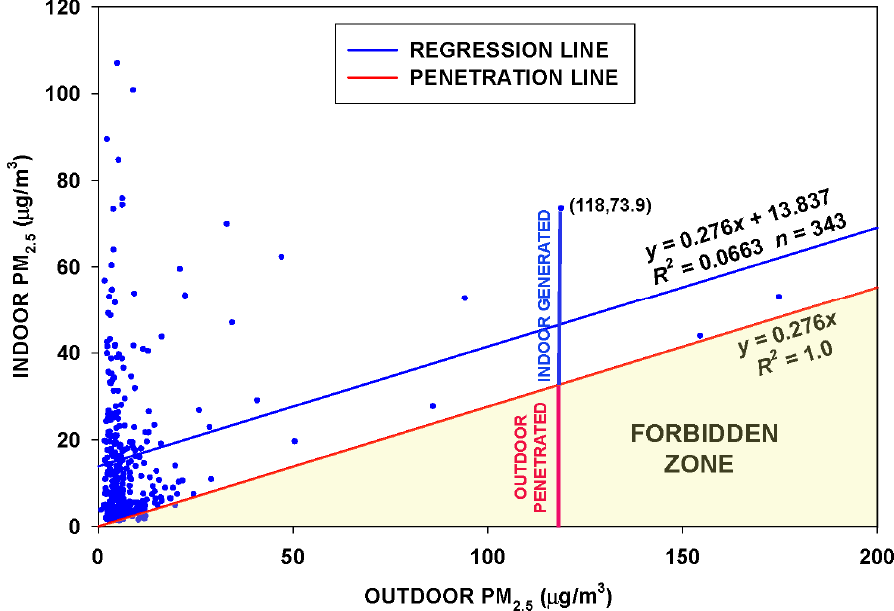
Figure 1. Regression of indoor on outdoor PM 2.5 measured over 343 days for a home. The slope of the regression line (blue) is the infiltration factor F inf . The parallel line (red) is the product of the infiltration factor F inf and the outdoor concentration. This line forms the upper boundary of a “Forbidden Zone”. No observed point should appear in this zone if F inf is constant and applies to all data, because it would indicate a negative indoor-generated concentration.